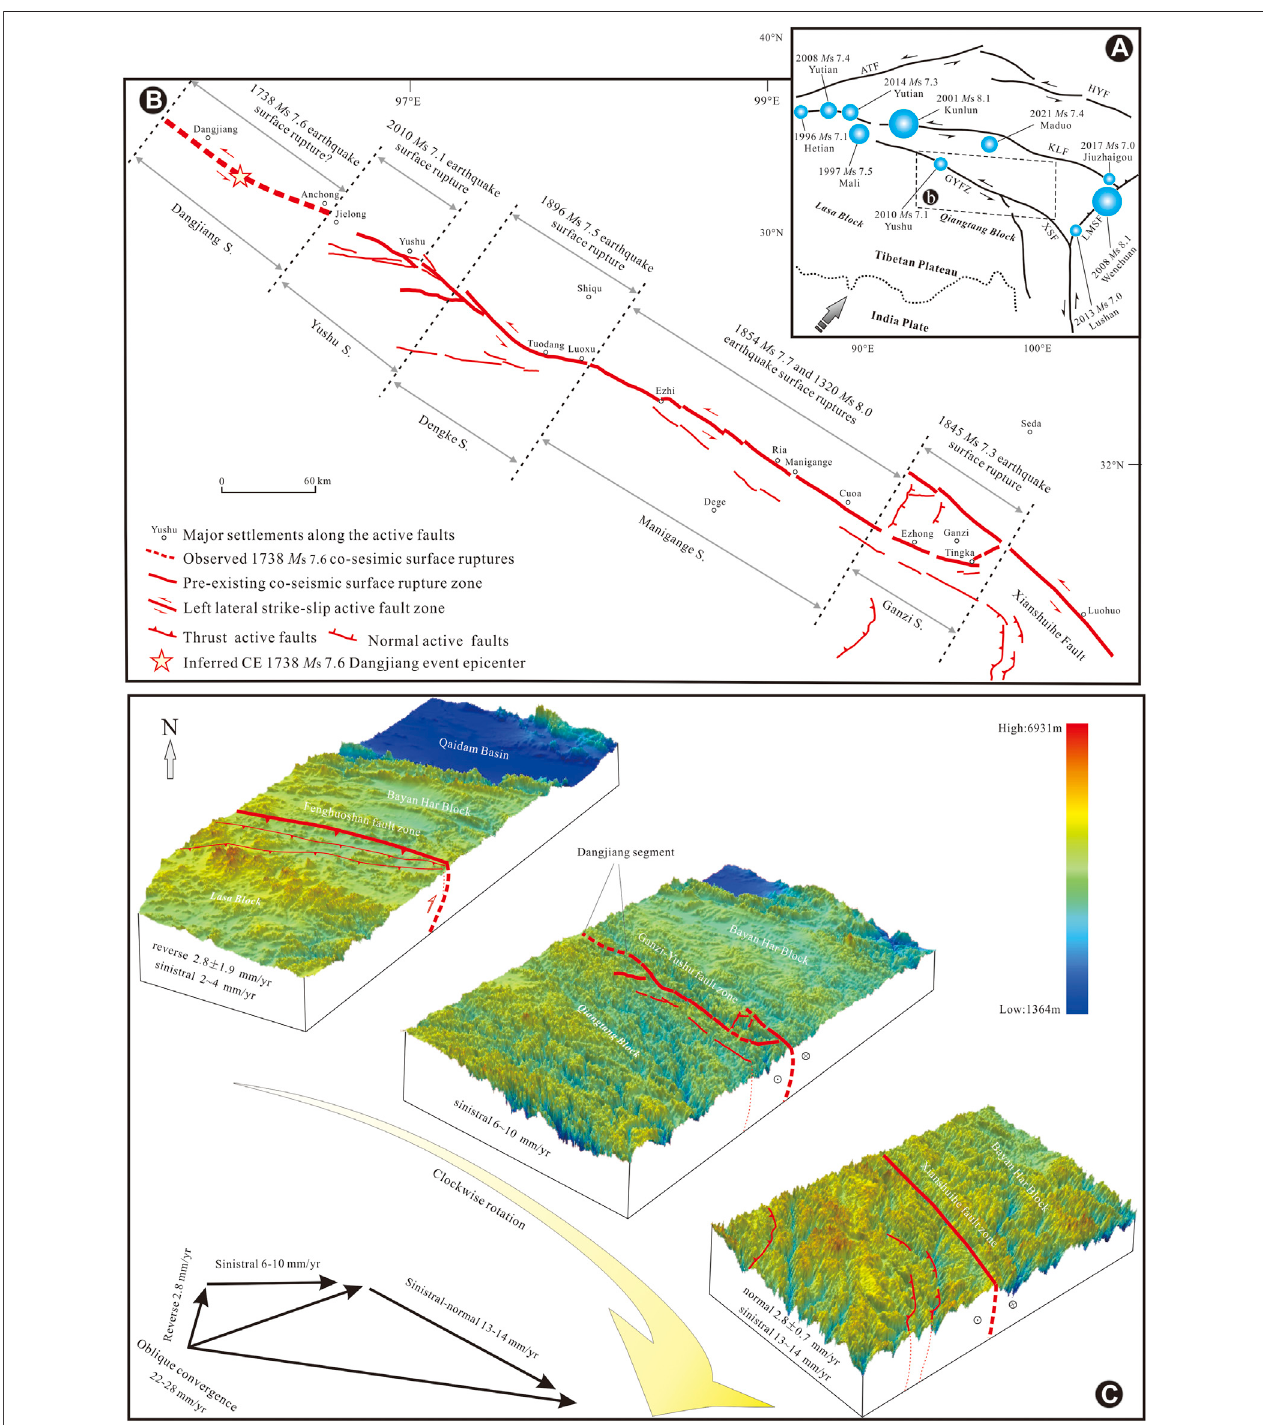
FIGURE 15 | Geometrics of the Ganzi-Yushu Fault Zone and the co-seismic surface ruptures resulting from historical great earthquakes along the northwestern continuationoftheXianshuiheFault Zone(XFZ)inthehighmountainareaofthecentral Qinghai-Tibetan Plateau. (A) Indexmap showing themajoractive faultsand great earthquakes around the Bayan Har Block boundary in the northern Qinghai-Tibet Plateau. ATF, Altyn Tagh Fault; HYF, Haiyuan Fault; KLF, Kunlun Fault; GYFZ, Ganzi- Yushu Fault Zone; LMSF, LongMenShan Fault Zone; XFZ, Xianshuihe Fault Zone, FFZ, Fenghuoshan Fault Zone. The gray – black arrow in the lower left corner approximately represents the direction of the northward subduction of the Indian Plate. (B) Sketch map showing the geometric distribution of the GYFZ and the co- seismic surface ruptures resulting from historical greatearthquakes along the structure. Dangjiang S, Dangjiang segment; Yushu S, Yushu segment; Dengke S, Dengke